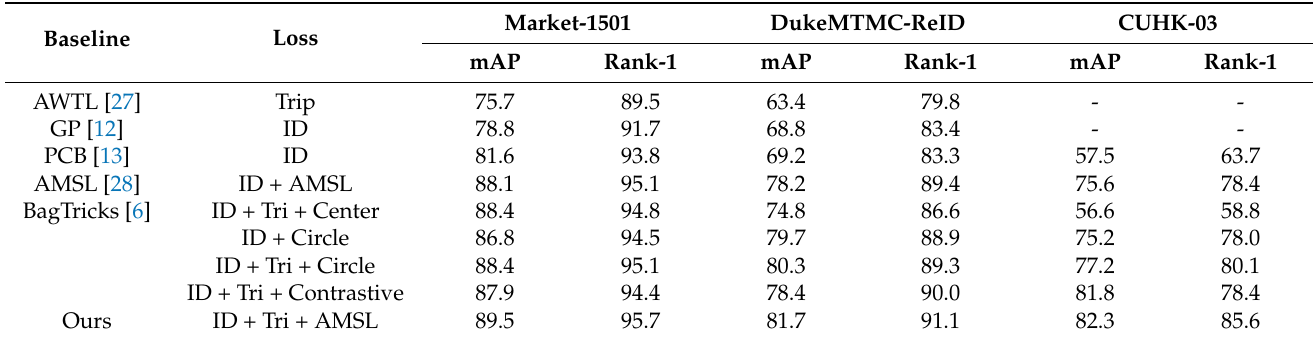
Table 3. Comparison of advanced baselines and different loss functions on three datasets.